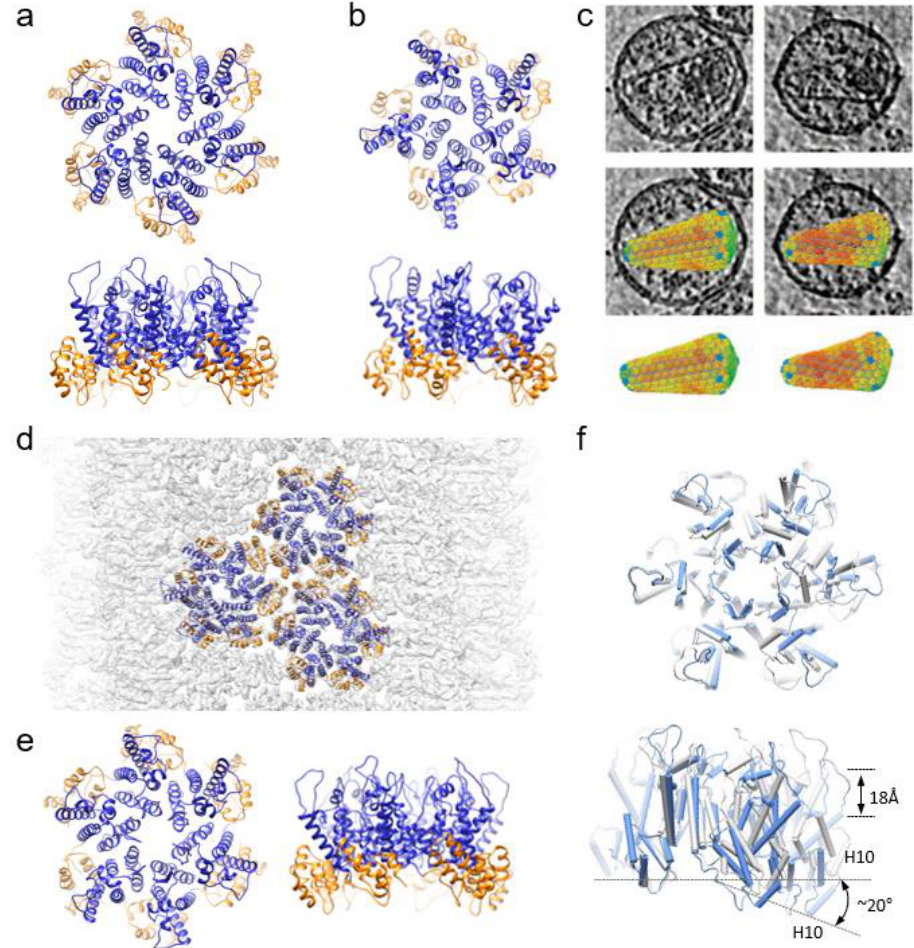
Figure 1. Structures of HIV-1 capsid assembly units. ( a–b ) Crystal structures of wild-type CA hexamer (PDB 4XFX) ( a ) and crosslinked CA pentamer (PDB 3P05) ( b ) viewed from top and side. CANTD-blue, CACTD,-gold ( c ) CryoET and subtomogram averaging of hexamers and pentamers from native virions. ( d–e ) overlapped with density map (EMDB- 10299) ( d ) CryoEM structure of of HIV-1 CA tubular assemblies with CA hexamer structure (PDB 6SKK ( e ). ( f ) Comparison of curved, asymmetric cryoEM hexamer (PDB 6SKK, blue) with the flat six-fold symmetric crystal hexamer (PDB 4XFX,